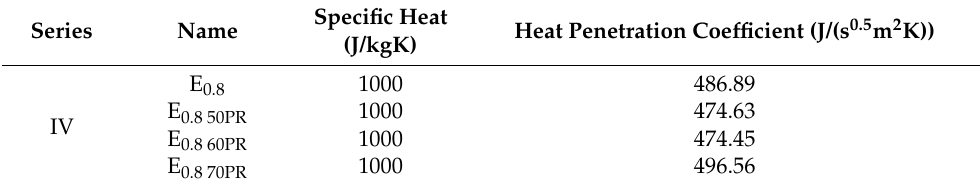
Table 5. Thermal comfort due to heat penetration coefficient.